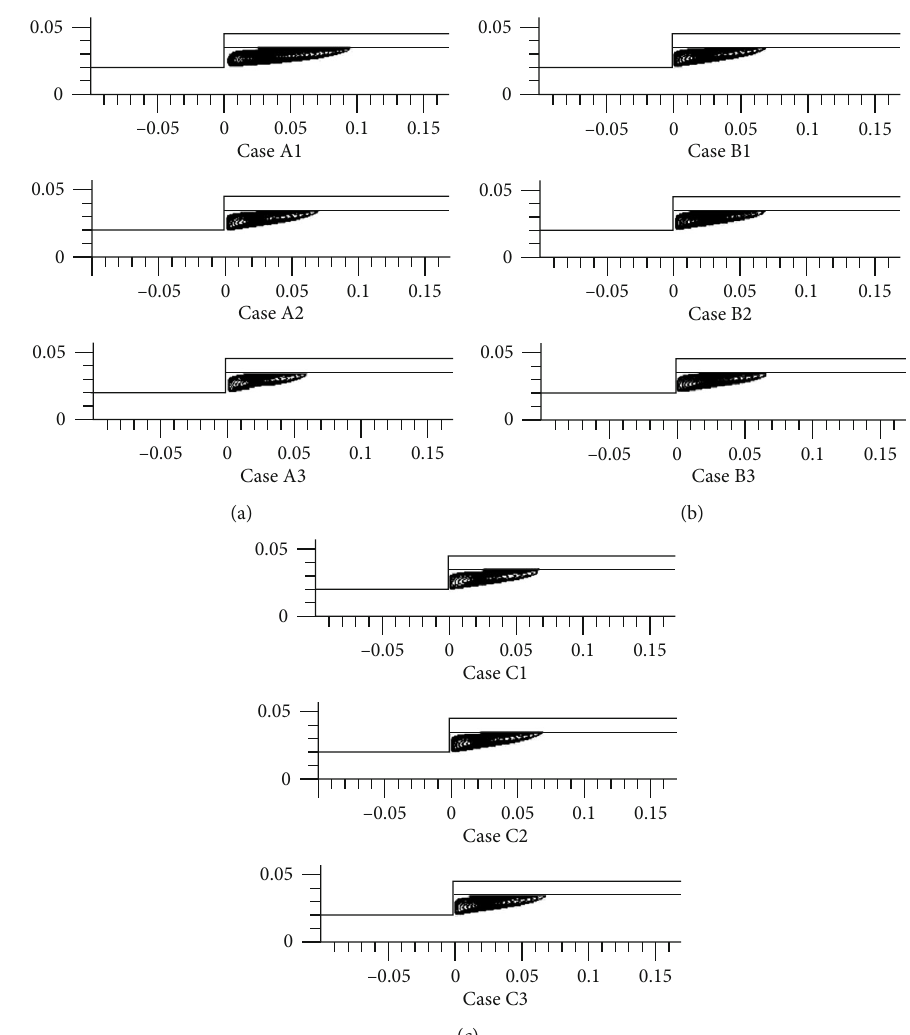
Figure 10: Streamlines for the cases with di ff erent inlet